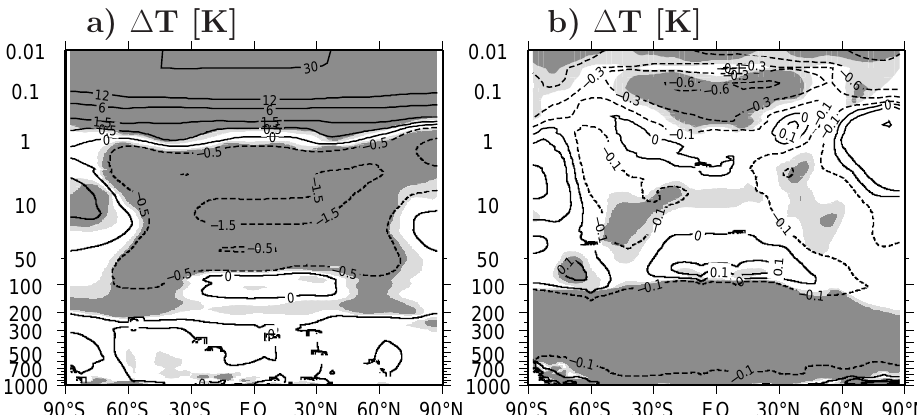
Fig. 6. Zonally averaged annual-mean temperature deviation (isolines in [K]) for the five simulation years 1999–2003. Shading refers to the 99% (dark-gray) and 95% (light-gray) significance levels from a paired t-test with four degrees of freedom. (a) simulation decoup full minus coup full . (b) coup rad minus coup full . Table 1 presents the simulation setups.